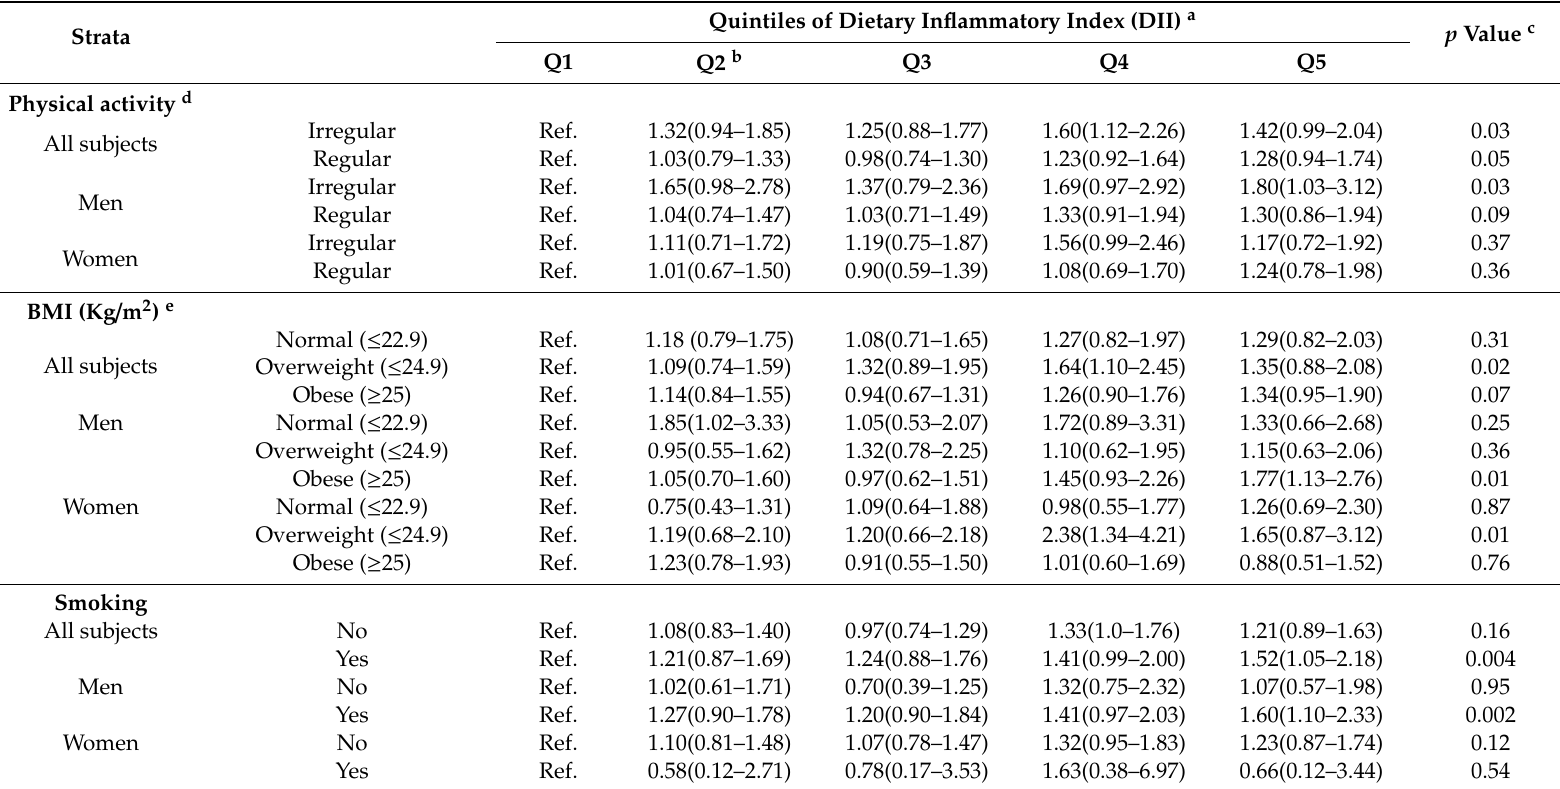
Table 4. Cox proportional HRs (95% Confidence Intervals (CIs)) for CVD risk by quintiles of DII score after stratification by physical activity, smoking, and